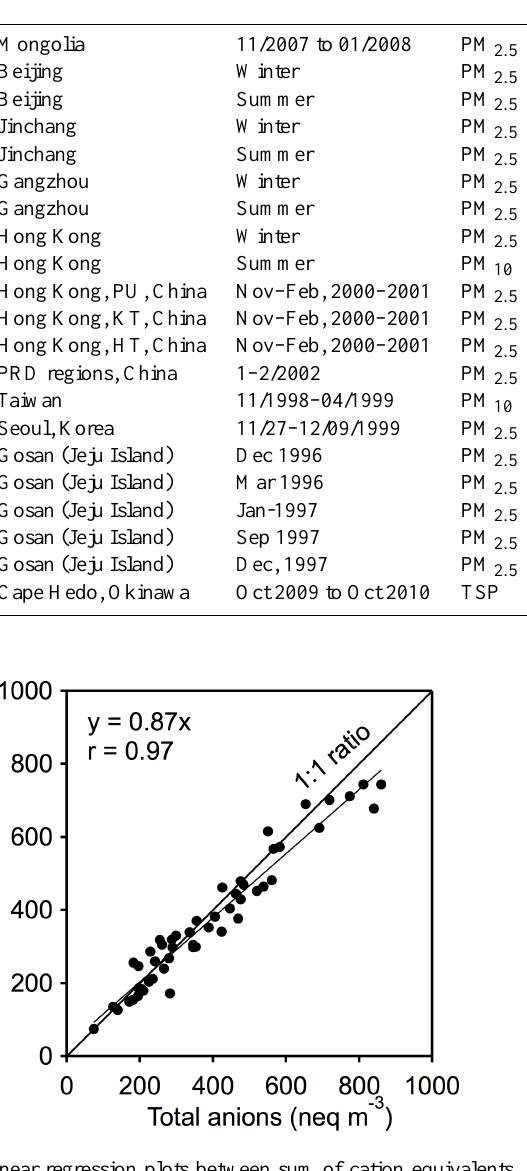
, SO 2 − , NH + in 3 4 4